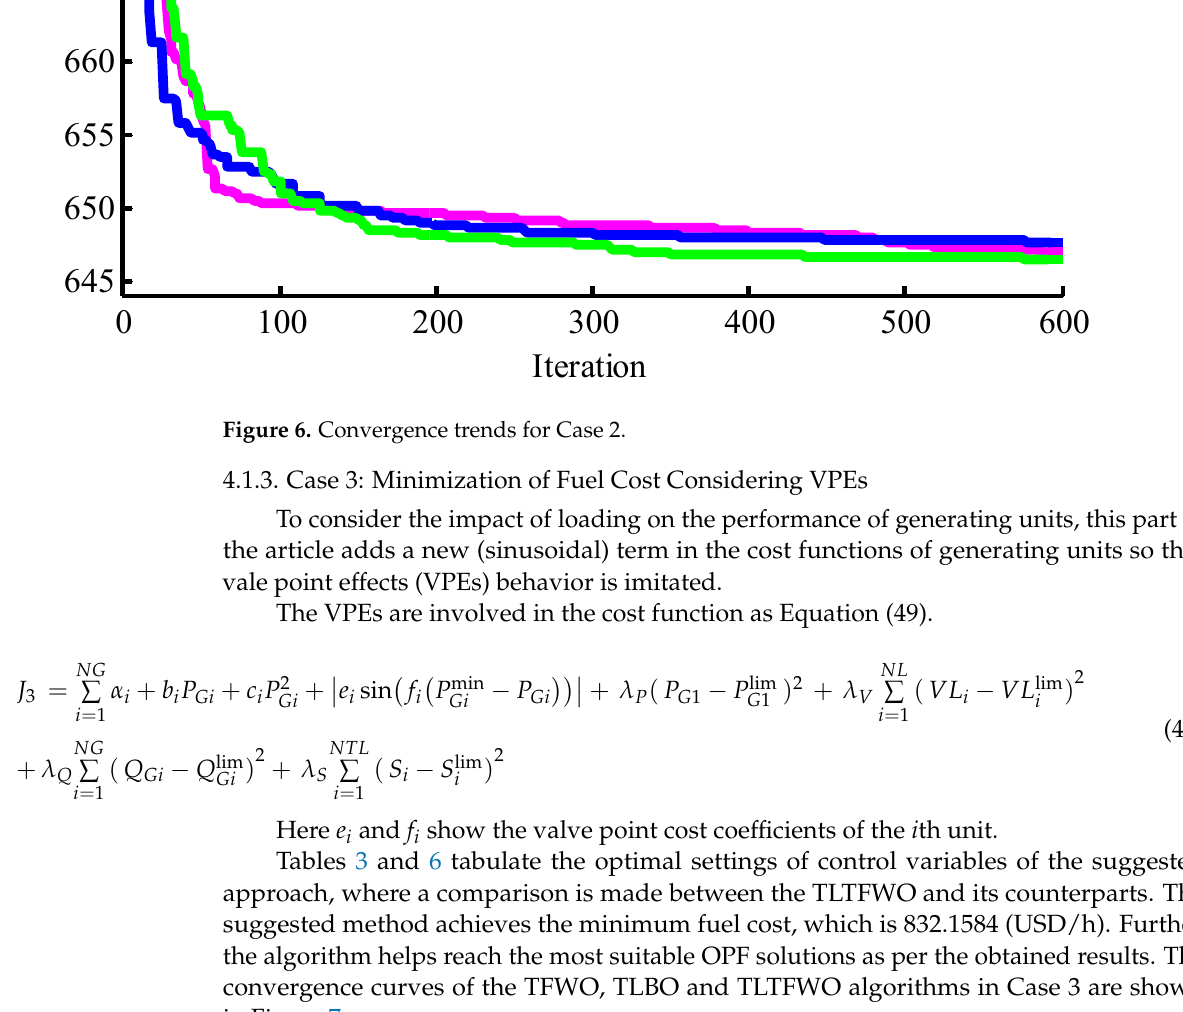
Table 6. Optimal results found by the TLTFWO in Case 3. Optimizer